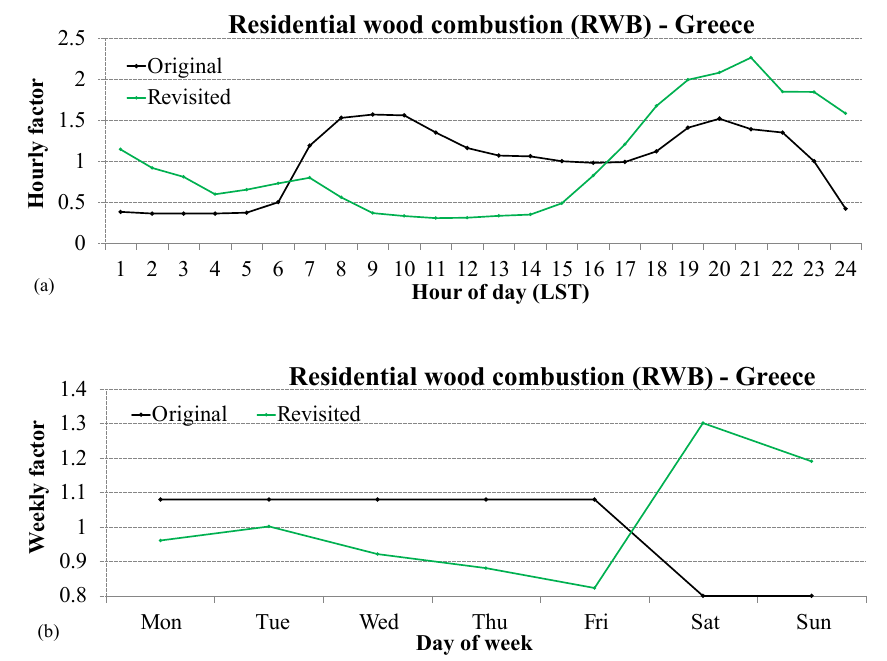
Figure 1. Original (black line) and revisited (green line) (a) diurnal and (b) weekly profiles applied to the emissions from residential wood combustion (RWB) in Greece (TNO-MACC_II database; Denier van der Gon et al., 2011). The revisited temporal profiles correspond to the mean values of the long-term measurements (2013–2015) of the wood burning fraction of black carbon (BC wb ) in Athens, normalized with respect to the average value of each